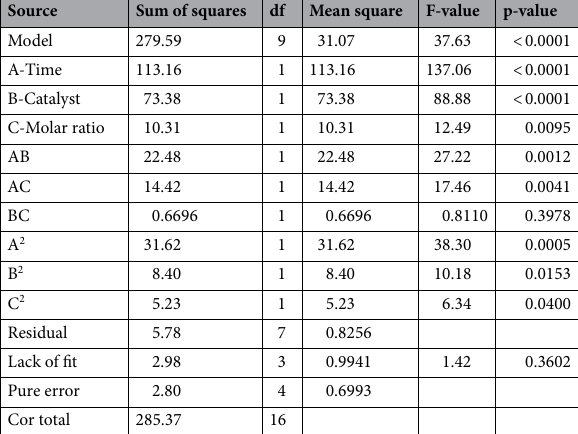
Source Sum of squares df Mean square F-value